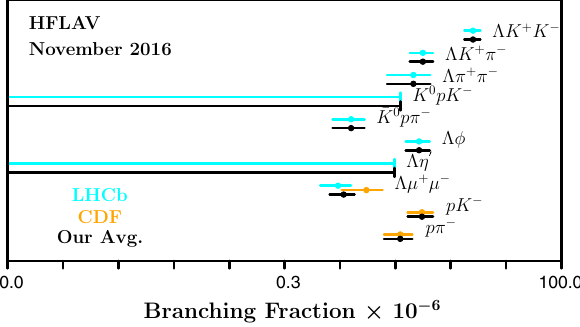
Results for LHCb are relative BFs converted to absolute BFs